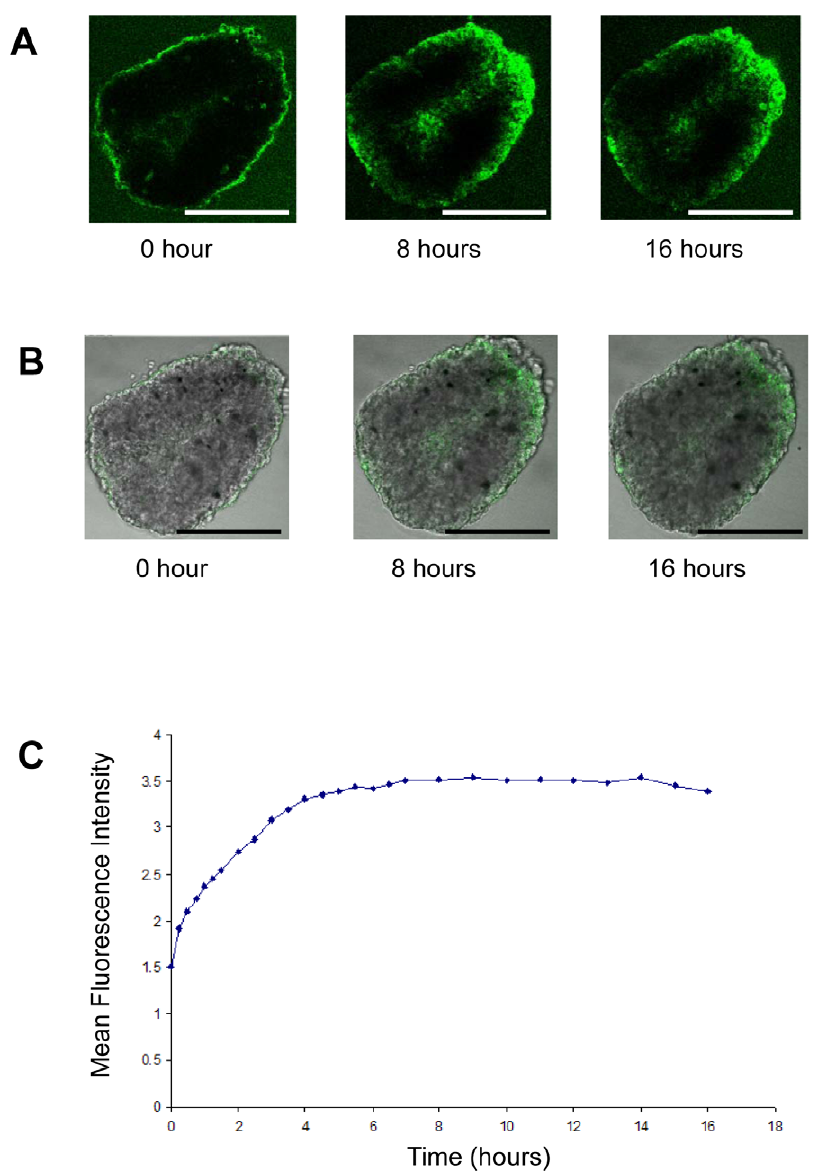
Figure 4. Penetration of Alexa488-labeled immunotoxin SS1P in tumor spheroids. A . SS1P labeled with Alexa488 (green fluorescence). A cross section close to the middle of an NCI-H226 spheroid evaluated at hours 0, 8 and 16 using confocal microscopy. B . Overlay of bright field and fluorescence images of a spheroid. C. Mean fluorescence intensity of SS1P (see Methods ). Scale bars, 400 m m.